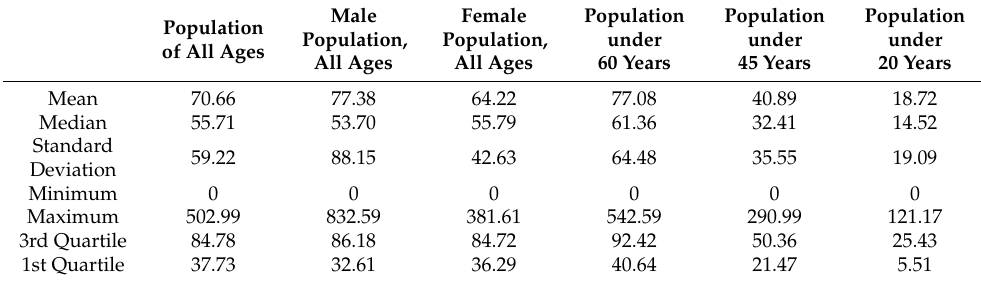
Table 2. Descriptive statistics for municipal crude mortality rates per 100,000 for chronic kidney disease, by gender and age group *, Guatemala 2009–2019 ( N = 340 municipalities). Male Female Population Population, of All Ages All Ages